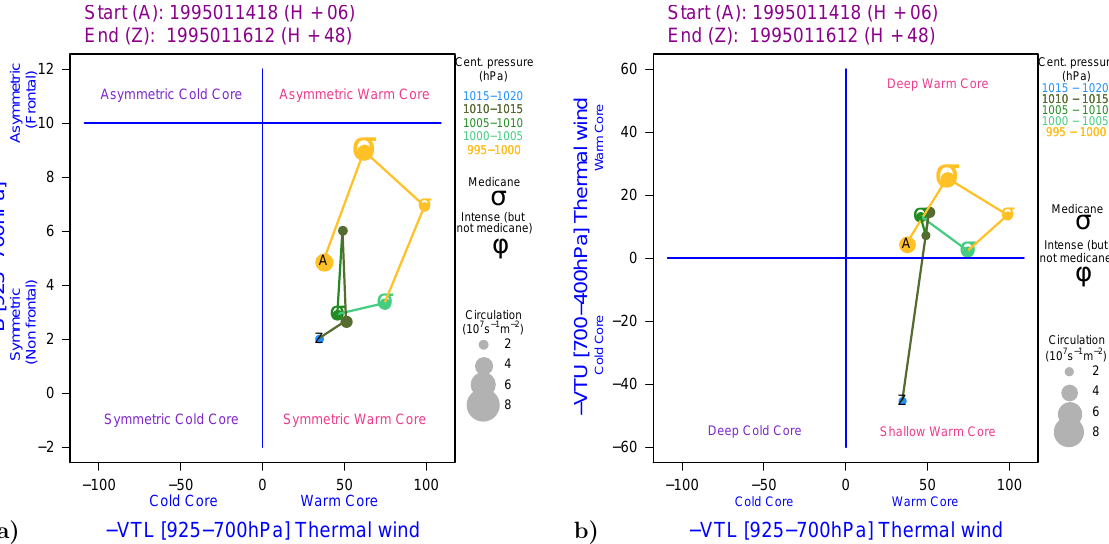
about 100 km during the most intense period up to around of 140 km. Minimum central pressure value is reached on 14 January at 12:00 UTC, agreeing with observed strong wind but with a higher value than the observed pressure. At 12:00 UTC on 15 January, the medicane is very small, with maximum values of the geostrophic vorticity and of the